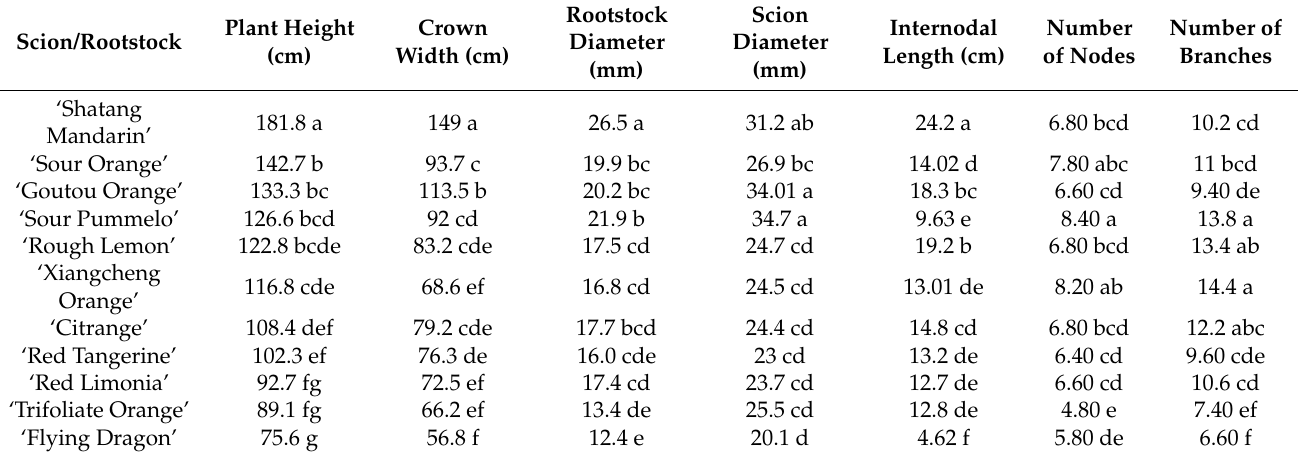
Table 2. Scion morphological characteristics of 1-year-old ‘Shatangju’ scion cultivar grafted onto different